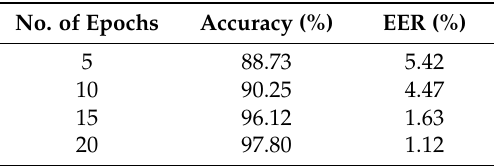
Table 3. Comparison of accuracy and EER for different iteration times.